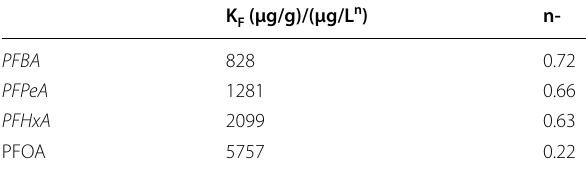
Table 5 Freundlich equilibrium parameters for PFAS